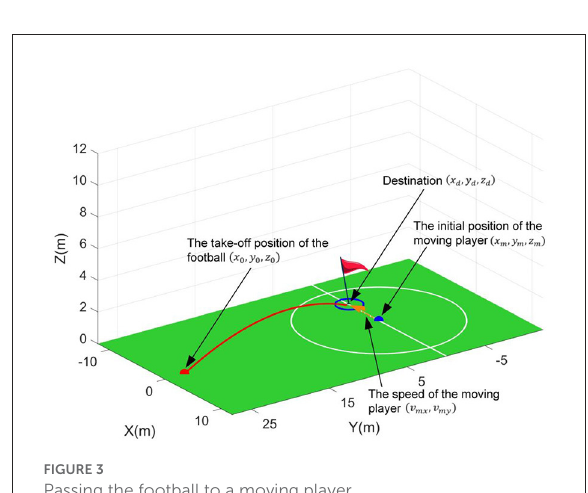
FIGURE3 Passing the football to a moving